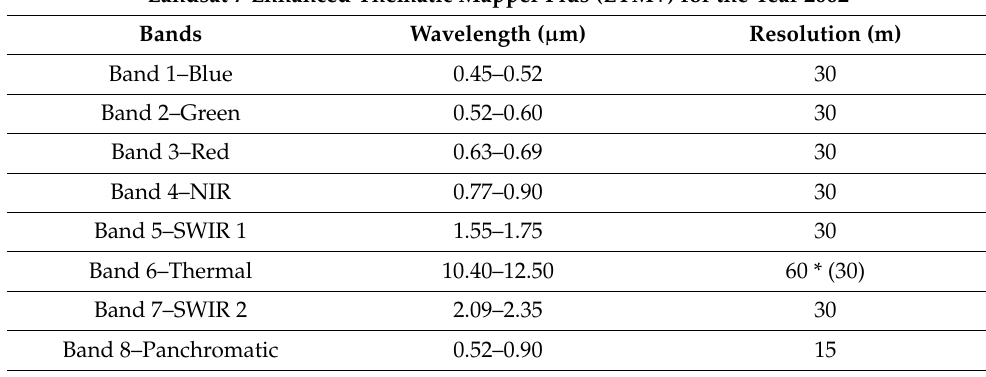
Table 2. List of the satellites used, the types of sensors captured, and their bandwidths. The imagery was taken from https://www.usgs.gov (accessed on 30 June 2021). The imagery was processed and analyzed using ENVI 5.1.